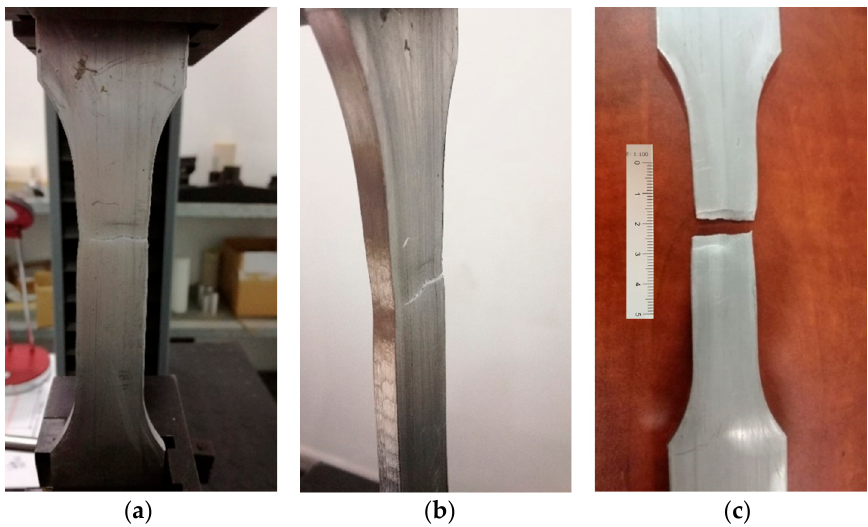
Figure 4. ( a , b ) Sample during the test; ( c ) Sample after the test (scale bar in